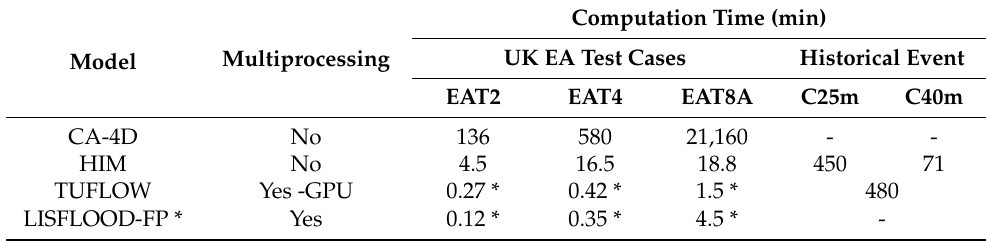
Table 3. Comparison of the computation